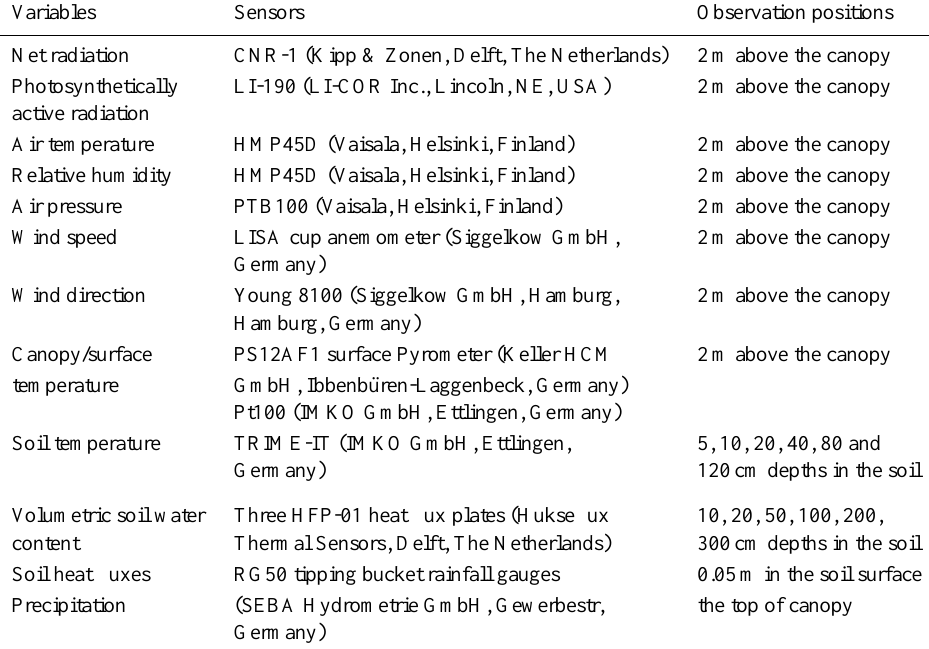
Table 1. The information of measured environmental variables by the EVINS Environmental Monitoring System. Variables